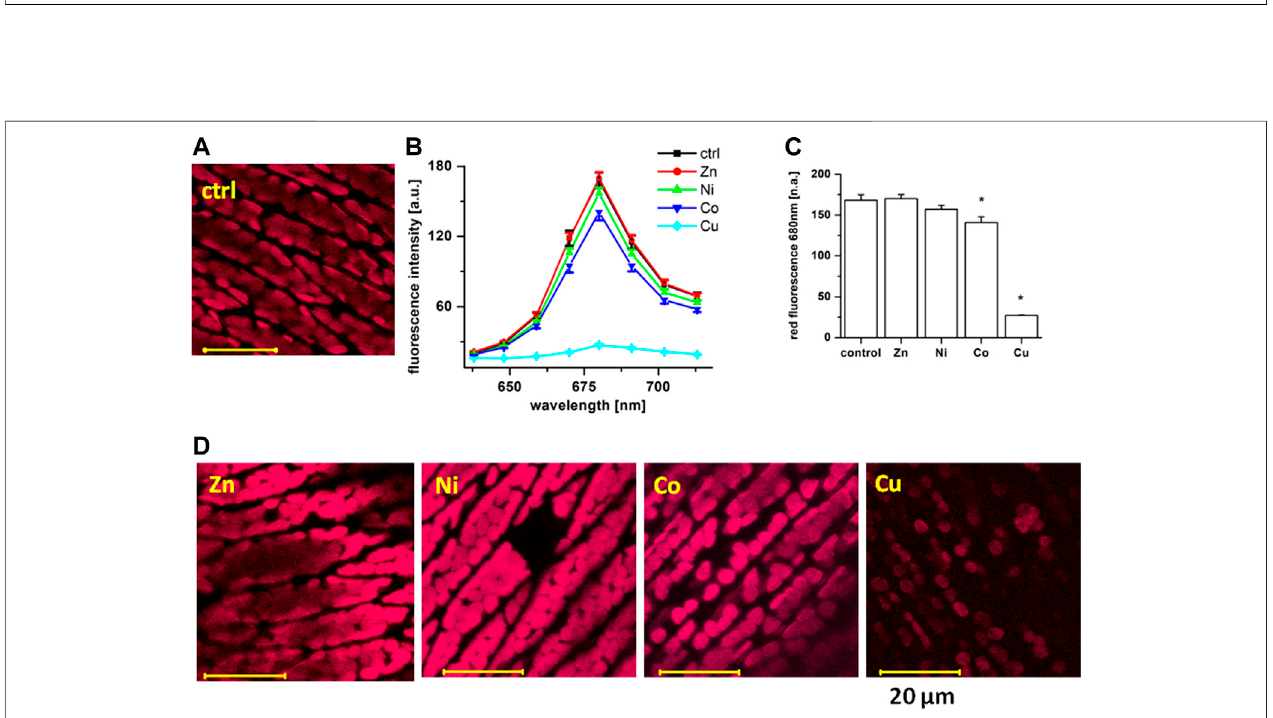
FIGURE 3 | Spectrally-resolved confocal microscopy images of Fontinalis antipyretica red fl uorescence. (A) An original lambda-coded image in control conditions takenwithan11 nmstepbetween638and713 nm,excitation450 nm. (B) ComparisonoftherecordedspectrainthepresenceofindividualNPs( n (cid:2) 42inCtrl, n (cid:2) 28in Zn, n (cid:2) 26inNi, n (cid:2) 36inCo, n (cid:2) 31inCu). (C) Statisticalcomparison at680 nm,* p < 0.05withone-wayAnova. (D) Spectrally-resolvedconfocalmicroscopyimagingof the red fl uorescence in the presence of Zn, Ni, Co, and Cu NPs, scale 20 μ m.